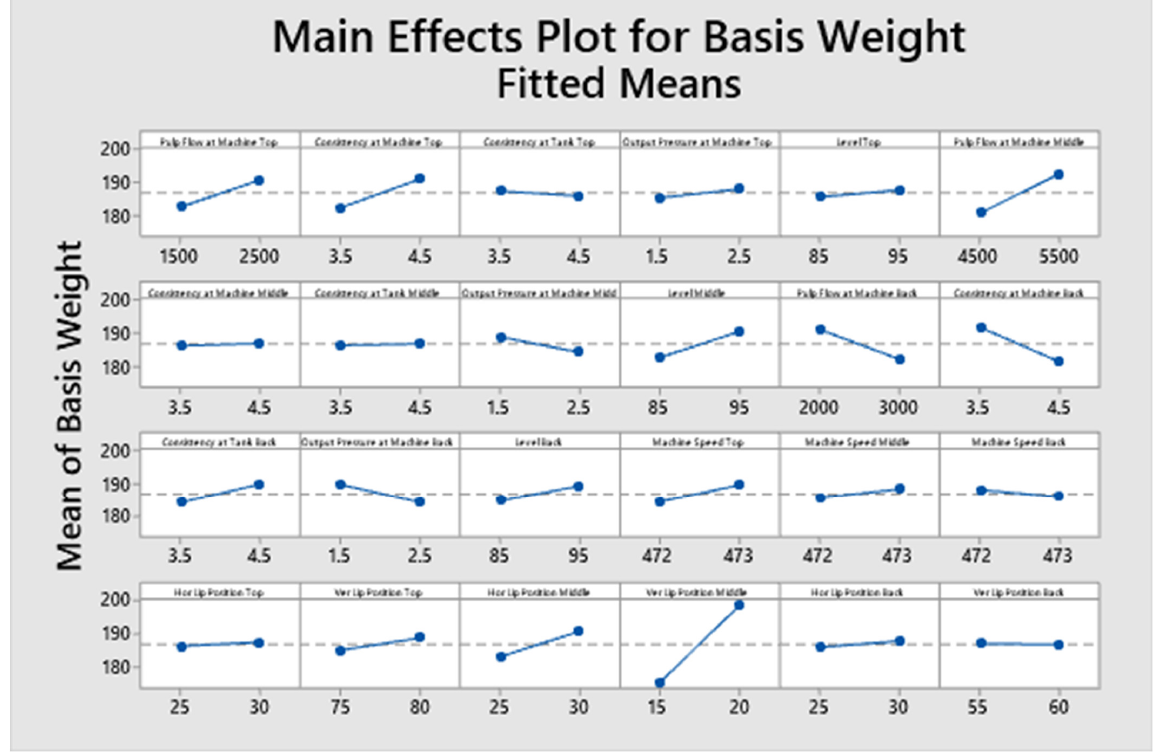
Figure 10. Main effects for the independent variables (correspond to the twenty-four variables as shown in Table 6). Table 6. Optimal operating conditions for each independent variable. Table 7. Predicted basis weight values (grams) to estimate the fuzzy process capability